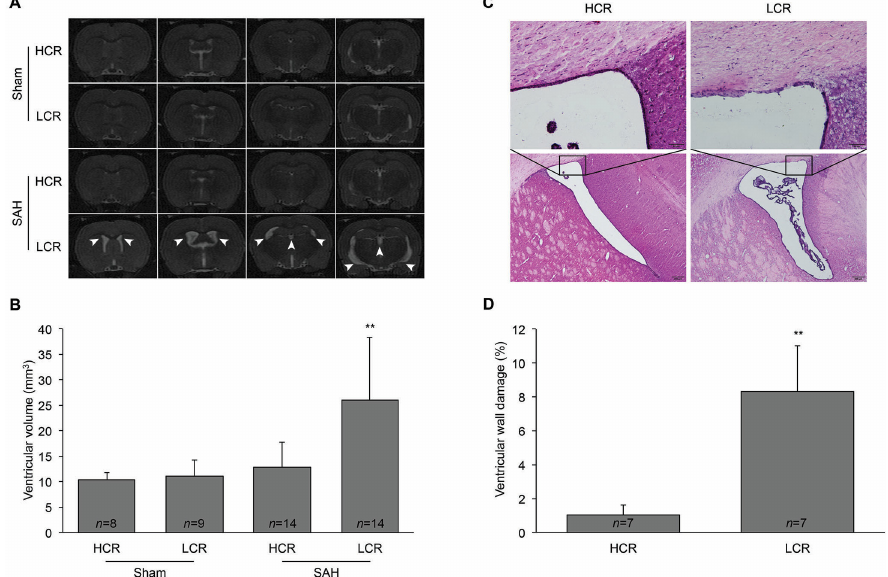
Figure 2. SAH induced hydrocephalus development and ventricular wall damage 24 h after endovascular perforation in LCR rats. ( A ) Representative T2-weighted MRI showing coronal brain section 24 h after SAH or a sham operation in LCR and HCR rats. The hyperintense signal shows brain ventricles. Enlarged ventricles in the LCR rats are indicated by white arrowheads. ( B ) Quantification of the ventricular volume from T2-weighted MRI 24 h after SAH or a sham operation in LCR and HCR rats. ( C ) Representative hematoxylin and eosin staining of brain sections showing ventricular wall damage 24 h after SAH or a sham operation in LCR and HCR rats. The top micrographs are enlargements of the boxed areas in the lower micrographs. Scale bars: top, 50 µ m; bottom, 200 µ m. ( D ) Quantification of ventricular wall damage 24 h after SAH or a sham operation (percentage of the damaged ventricular wall in the total ventricle wall length). Values are mean ± SD; ** p < 0.01 versus HCR